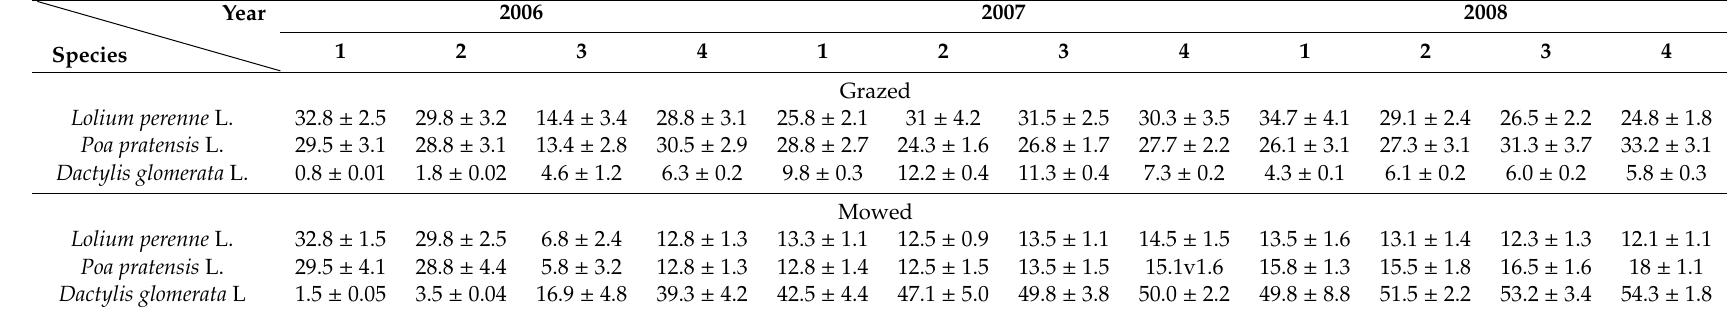
Table A1. The in-season variability of main grass species in the pasture sward in consecutive years of study in dependence on the management system.